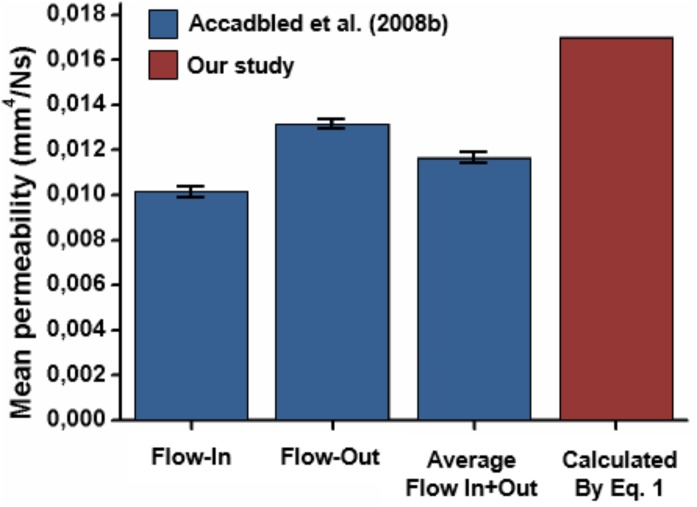
Comparison of the permeability value obtained by Equation 1 and experimental values: flow-in, flow-out, and average of flow-in and flow-out reported by Accadbled et al. (2008).